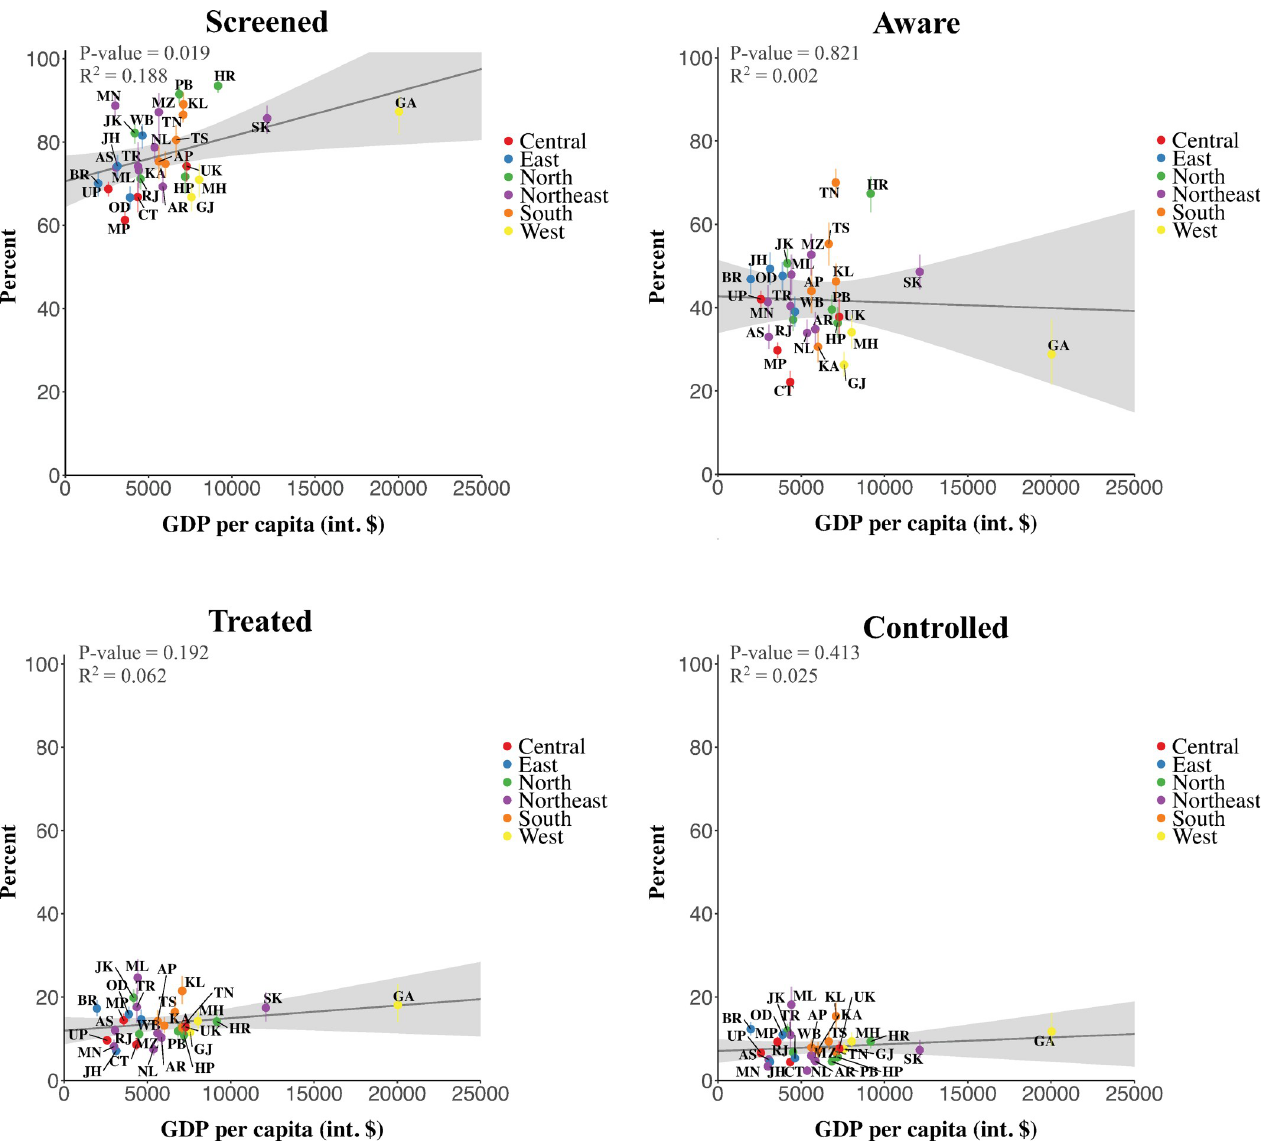
Fig 3. The association between state gross domestic product (GDP) per capita and each cascade step. State population estimates were obtained from the 2011 census of India, and GDP data (for 2013/2014) were obtained from the Central Statistics Office, Ministry of Statistics and Programme Implementation, Government of India [15,31].Indian rupee values were converted to 2015 international dollars (int. $) using the purchasing power parity conversion factors published by the World Bank [32]. The grey ribbon depicts the pointwise 95% prediction interval. The vertical bars depict 95% confidence intervals. P values refer to the regression coefficient of the ordinary least squares regression line (with each state having the same weight) shown in the figure. Similarly, R 2 values are for the ordinary least squares regression of states’ cascade achievement onto their GDP per capita. States were divided into regions as per their allocation to Zonal Councils by the Government of India [33]. Union territories were excluded from this figure because of the unavailability of GDP information for 3 of the 7 union territories. AP, Andhra Pradesh; AR, Arunachal Pradesh; AS, Assam; BR, Bihar; CT, Chhattisgarh; GA, Goa; GJ, Gujarat; HP, Himachal Pradesh; HR, Haryana; JH, Jharkhand; JK, Jammu and Kashmir; KA, Karnataka; KL, Kerala; MH, Maharashtra; ML, Meghalaya; MN, Manipur; MP, Madhya Pradesh; MZ, Mizoram; NL, Nagaland; OD, Odisha (Orissa); PB, Punjab; RJ, Rajasthan; SK, Sikkim; TN, Tamil Nadu; TR, Tripura; TS, Telangana State; UK, Uttarakhand (Uttaranchal); UP, Uttar Pradesh; WB, West